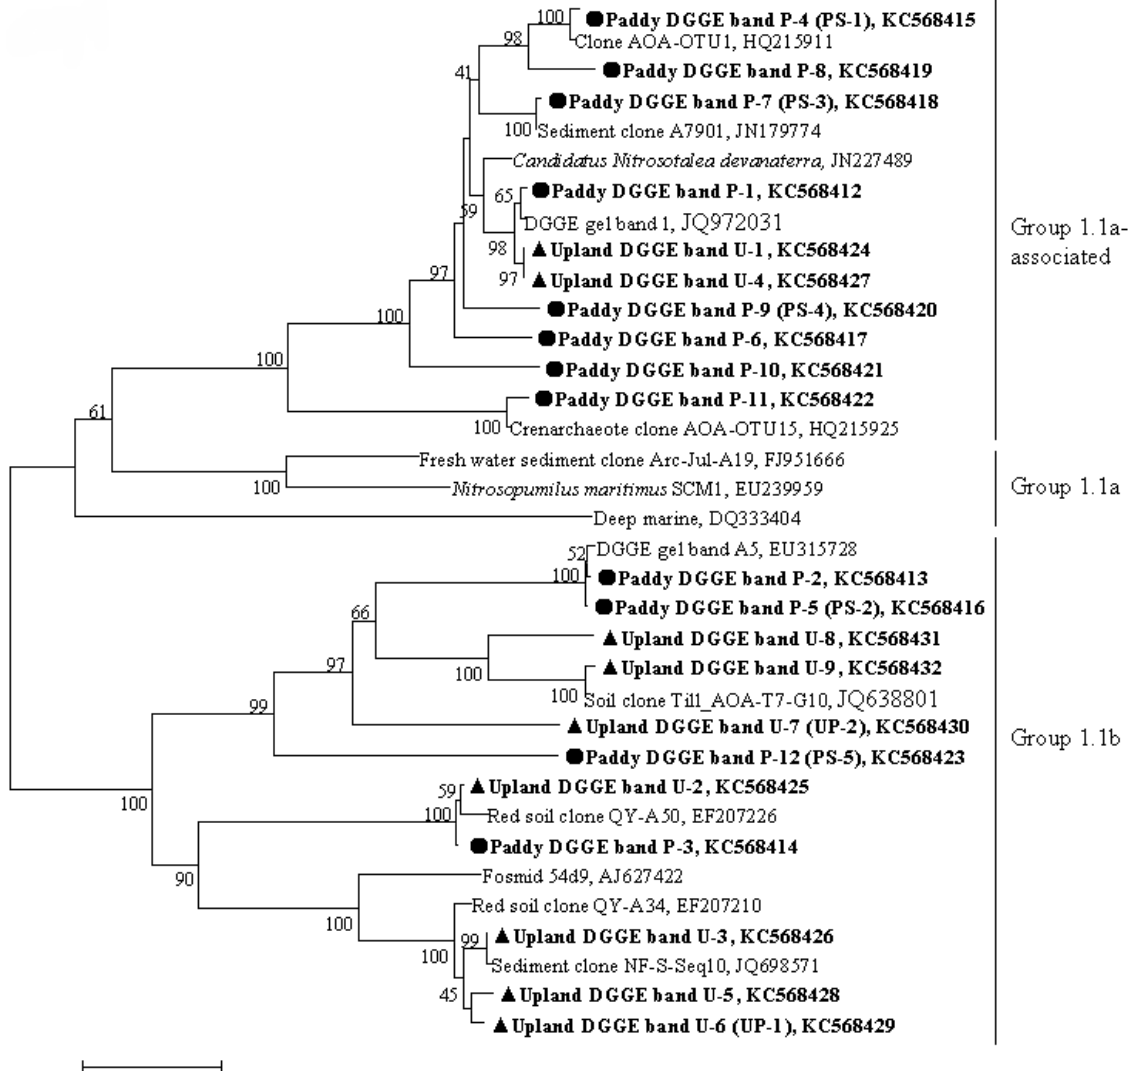
Fig. 3. Neighbor-joining tree showing the relationships of the archaeal amoA genes retrieved from the DGGE bands of upland and paddy soils to those in GenBank. The scale bar indicates 5 changes per 100 nucleotide acid positions. Bootstrap values ( > 40%) are indicated at branch points. Sequences from this study are shown in bold. N represents the sequences derived from upland soil, and • represents the sequences derived from paddy